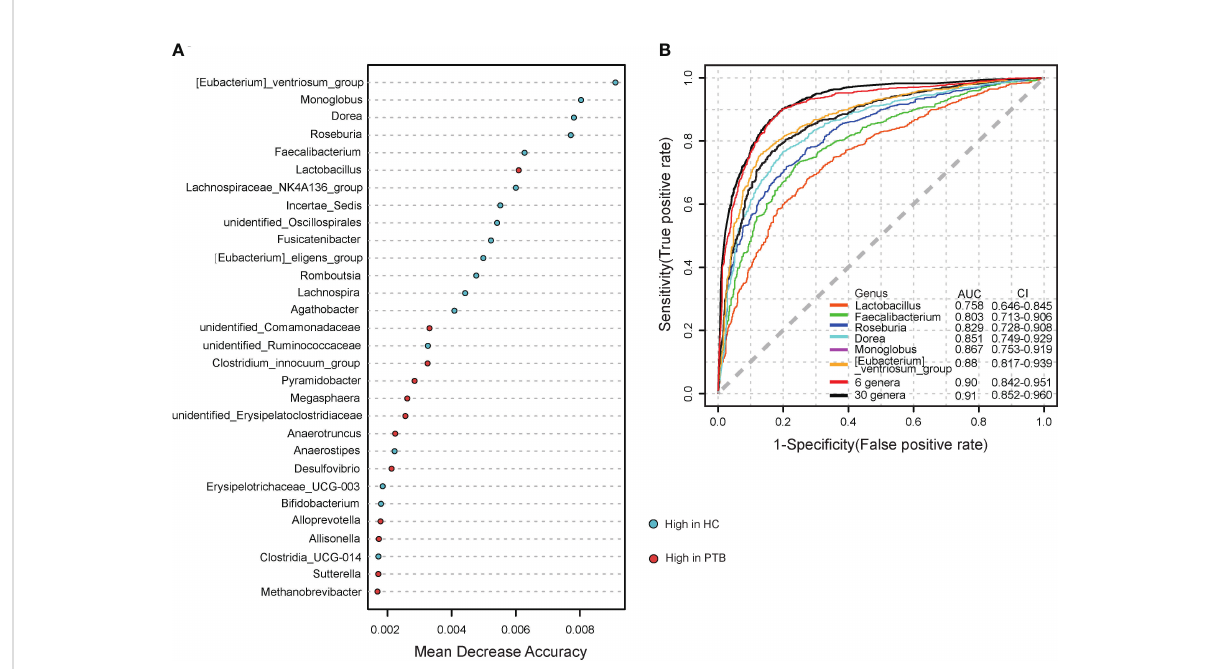
FIGURE 5 Establishing random forest models to predict the biomarkers of gut microbiota in PTBs. (A) The top 30 genera were selected to establish a random forest classi fi er for the diagnosis of PTB. The mean value enriched in HCs(blue); The mean value enriched in PTB patients (red). (B) Receiver operating characteristic (ROC) analysis of Lactobacillu , Faecalibacterium, Roseburia, Dorea, Monnoglobus, [Eubacterium]_ventriosum_ group, 6 genera mentioned above and the 30